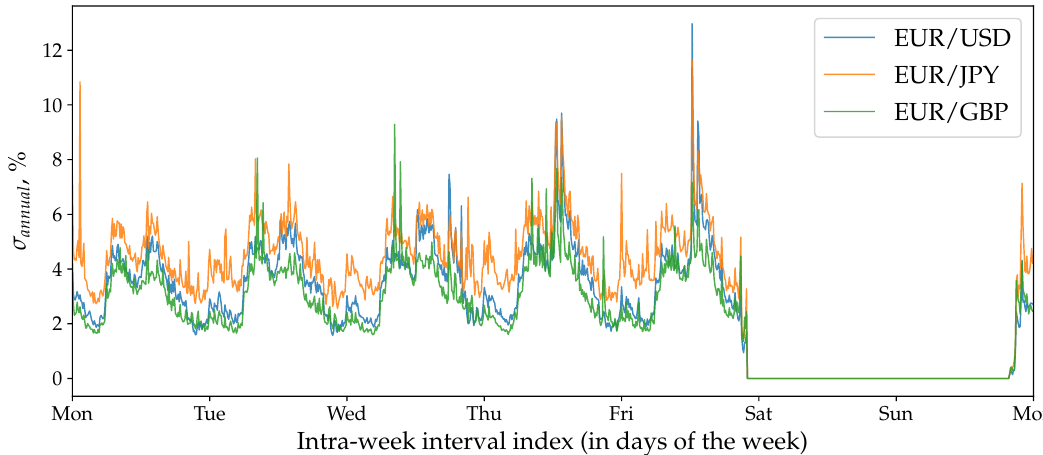
Figure 7. Realised volatility seasonality patterns of three FX exchange rates computed using the traditional approach (Equation (20)). Time intervals of 1-min have been used to calculate returns. The size of each bin is 10 min, 1008 bins in total.